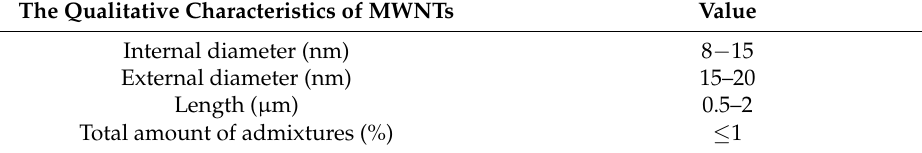
Table 3. Properties of